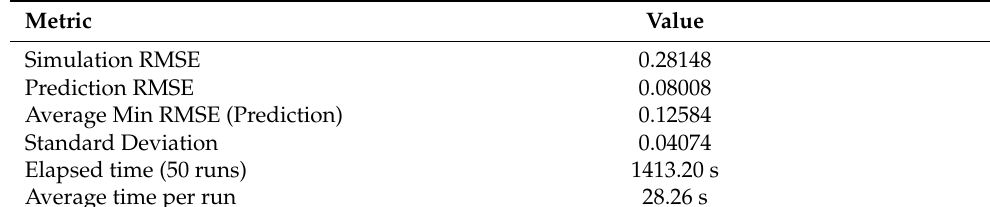
Figure 11. Output from simulation (green) using the best found individual for the Silverbox problem, compared to the empirical data (blue). Table 8. Experimental results from the Coupled Drives problem.